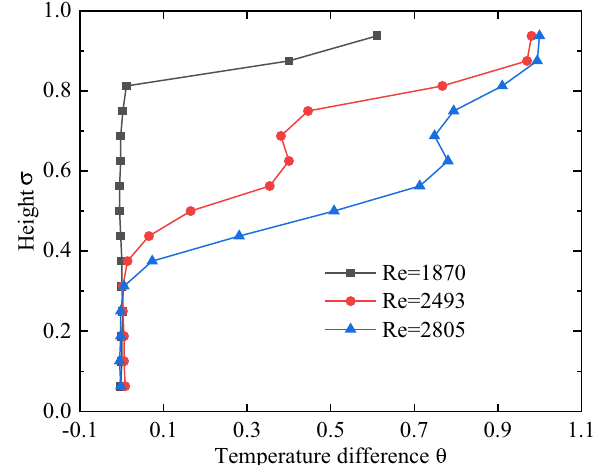
Fig. 22 Temperature change of L1 when Fo is 0.9 with inner tube diameter of 23